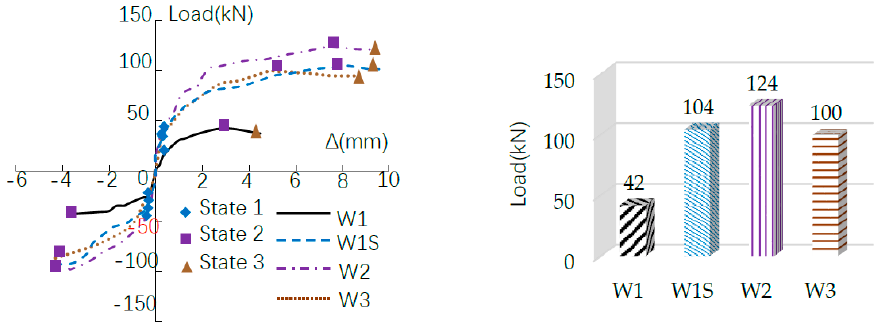
Figure 8. In-plane shear resistance of the walls: ( a ) Skeleton curves; ( b ) resistance.